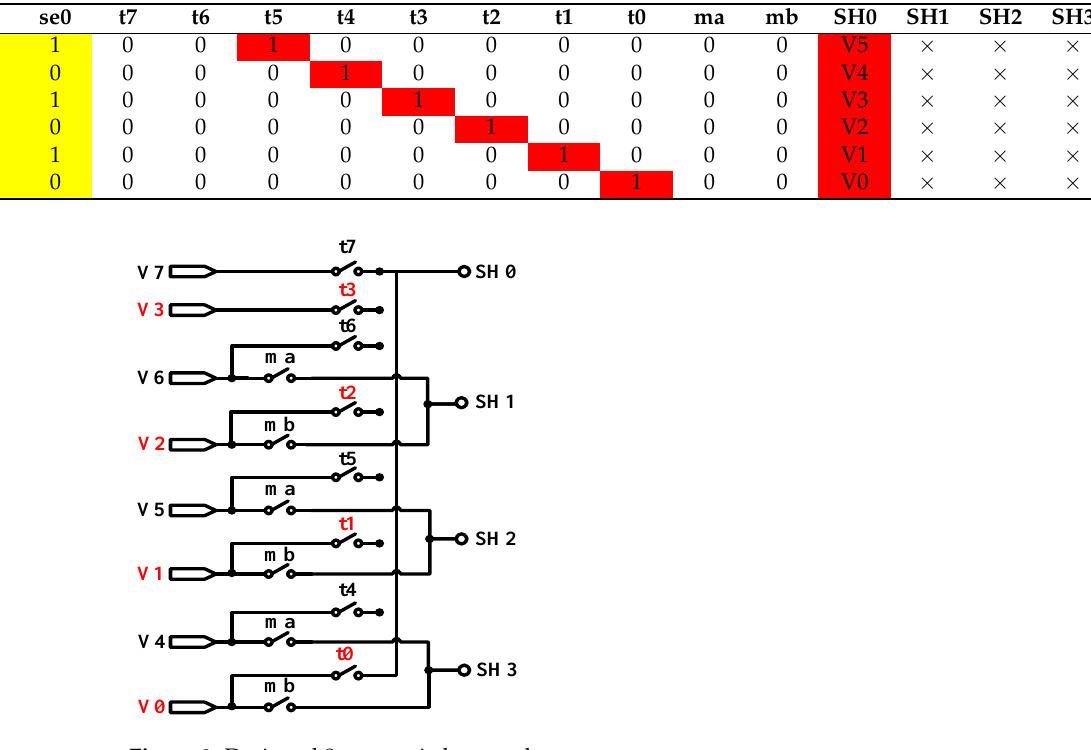
Figure 3. Designed 8-way switch control system. Table 1. Control signals of the 8-way switch control system.